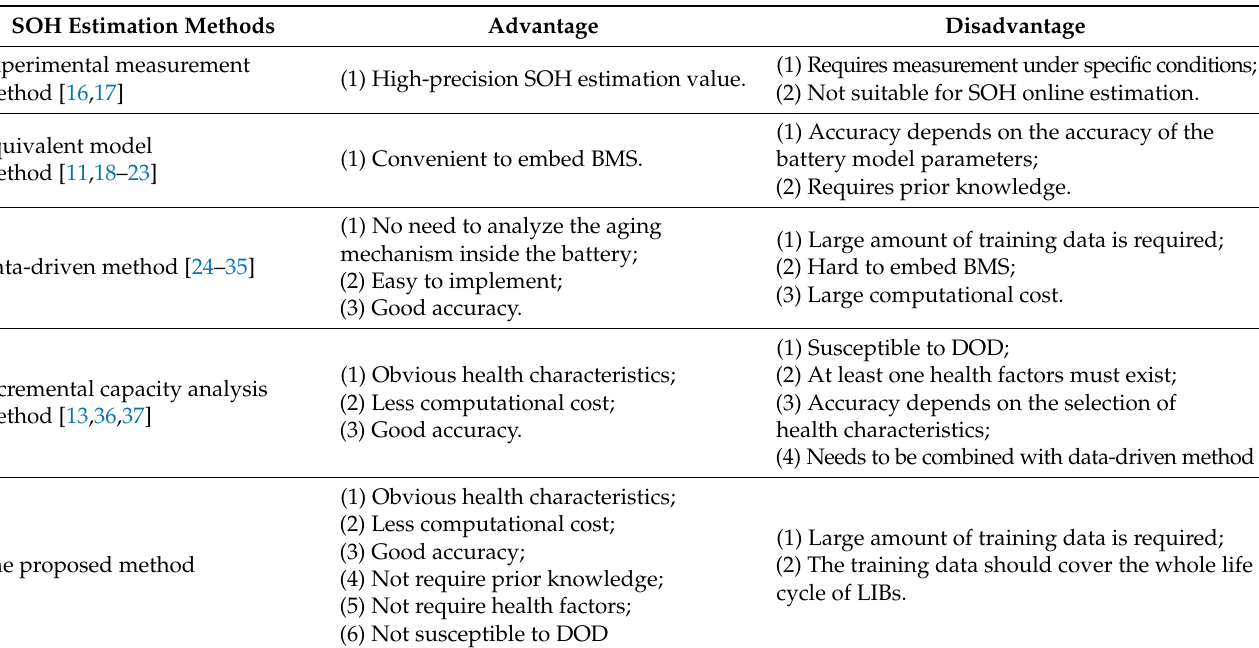
Table 1. Comparison of SOH estimation